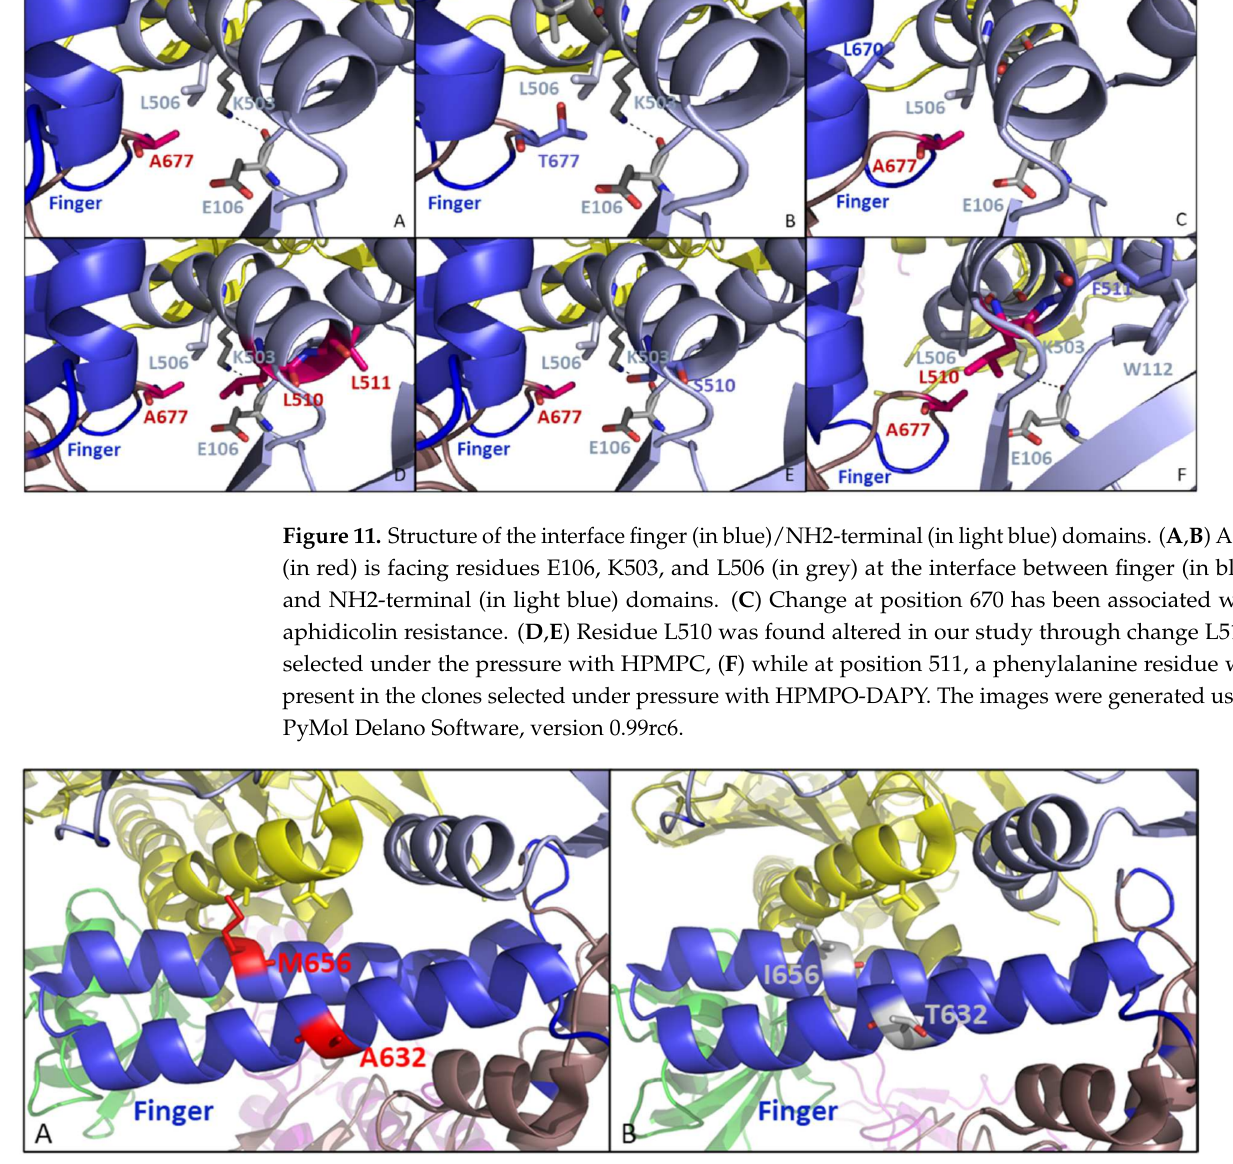
Figure 12. ( A ) Finger domain, represented in blue, is the location of two amino acid changes identified in position A632 and M656 (represented in red). ( B ) The amino acid changes, represented in grey, might involve differences in positioning of the finger domain for proper recognition of the incoming substrate. The images were generated using PyMol Delano Software, version